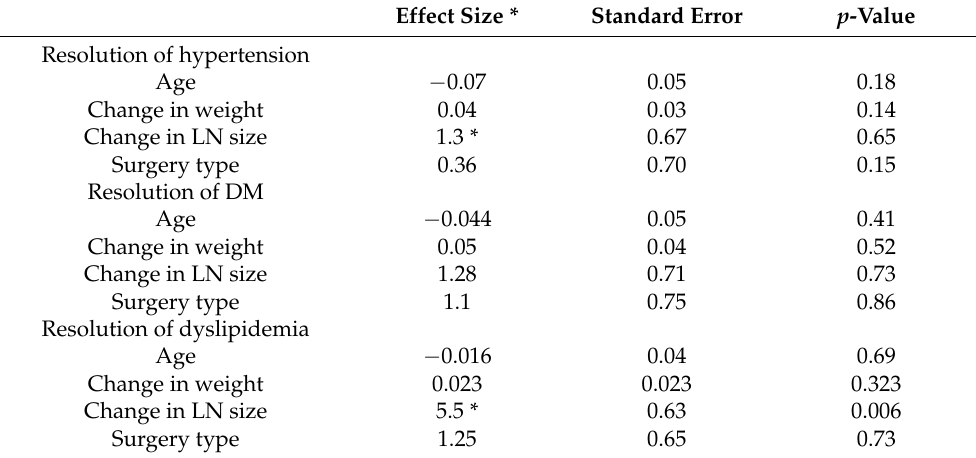
Table 3. Results of the multivariate linear model comparing the resolution of hypertension, diabetes, or dyslipidemia with a change in lymph node size. The effect size is represented by regression coefficients for continuous variables or by the adjusted odds ratios binary variables. Patients with a change in lymph node size were compared to patients without a change in node size, and patients who underwent a Roux-en-y gastric bypass surgery were compared to patients who underwent a sleeve gastrectomy. Weight is expressed in kilograms and lymph node size (LN) is expressed in